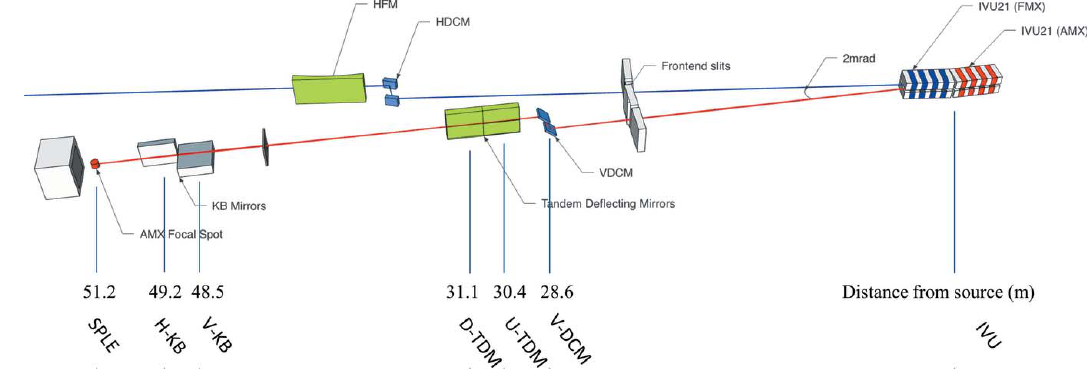
Figure 1 The AMX beamline layout (not to scale). AMX is served by the upstream (17-ID-1) IVU21 undulator, FMX by the downstream (17-ID-2) one. The beam of AMX is shown in red and that of FMX in blue. All distances are given with respect to the center of the short straight section, between the two undulators. The distance between the center of the AMX IVU and the center of the short straight section is 1.3